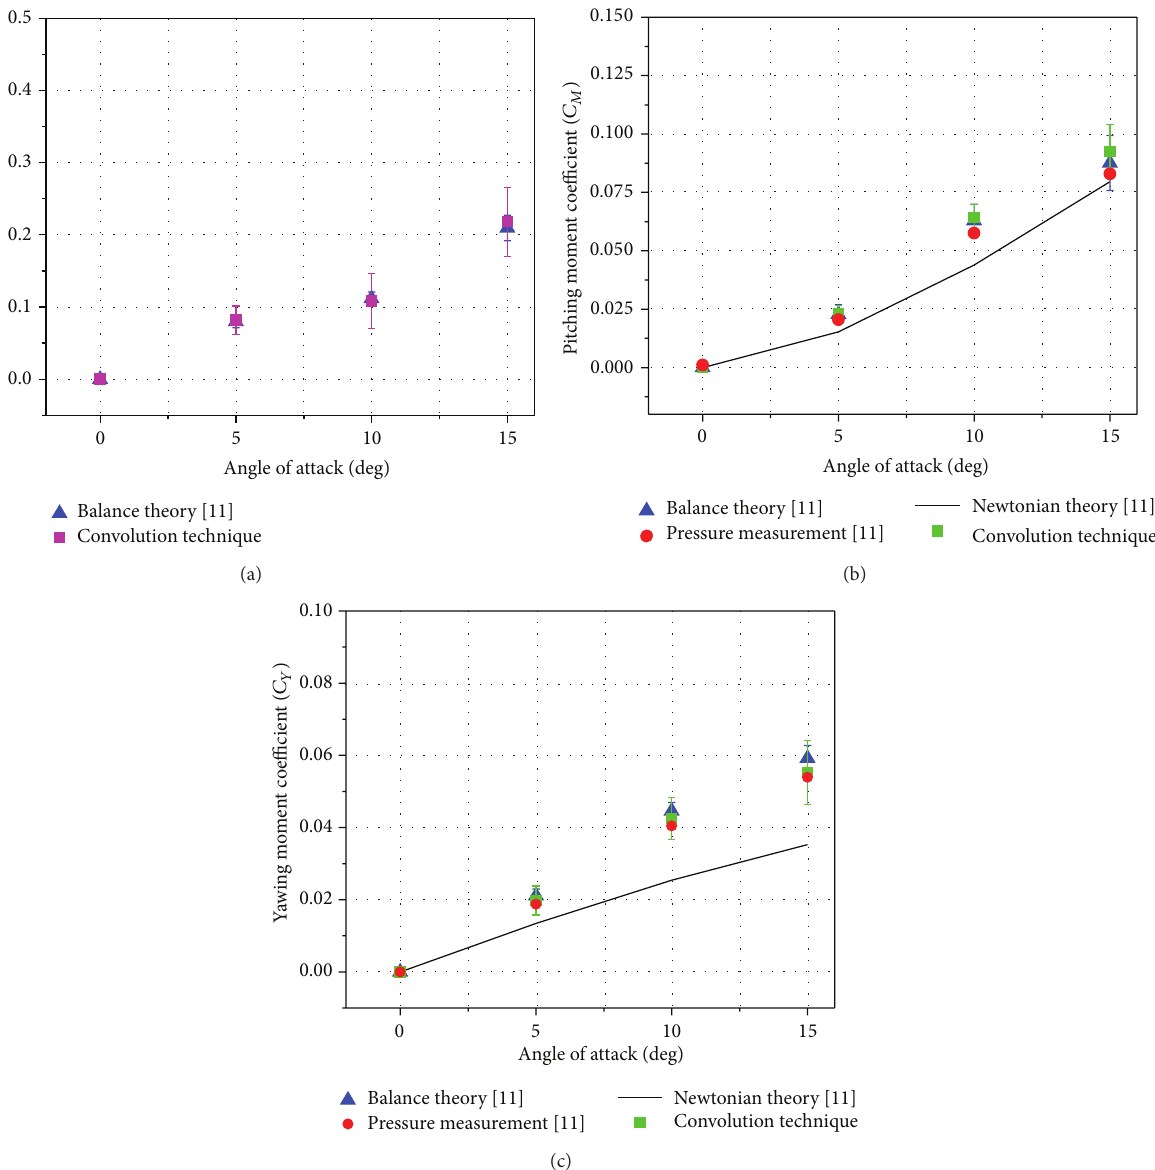
Figure 9: Variation of (a) side force, (b) pitching, and (c) yawing moment coefficients with model AOA. The scatter bars indicate standard